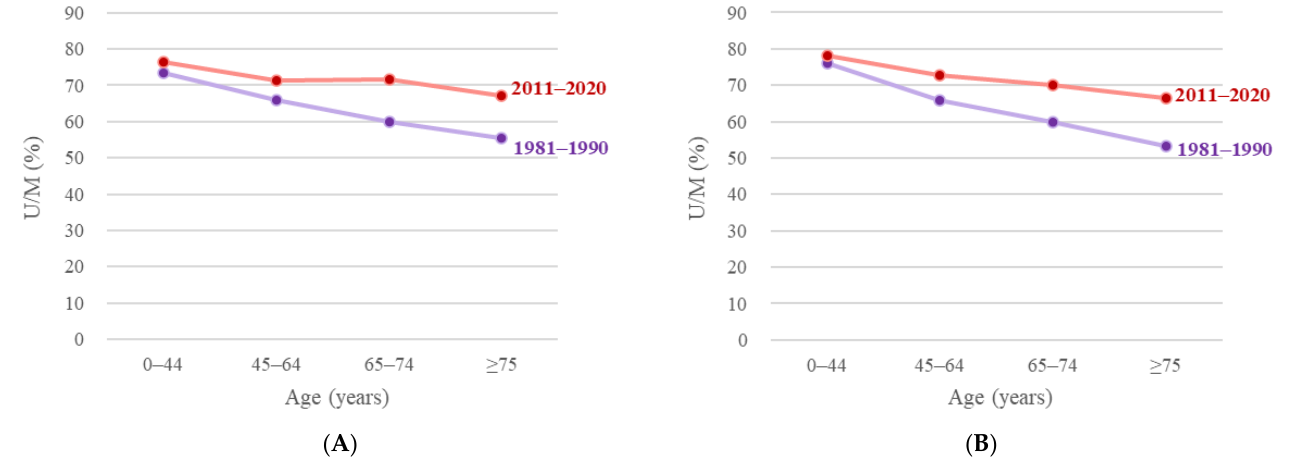
Figure 2. Proportion of number of deaths according to underlying cause of death (U) among those according to multiple causes of death (M) in systemic sclerosis mortality by sex in the United States, 1981–1990 versus 2011–2020. ( A ) Men. ( B )